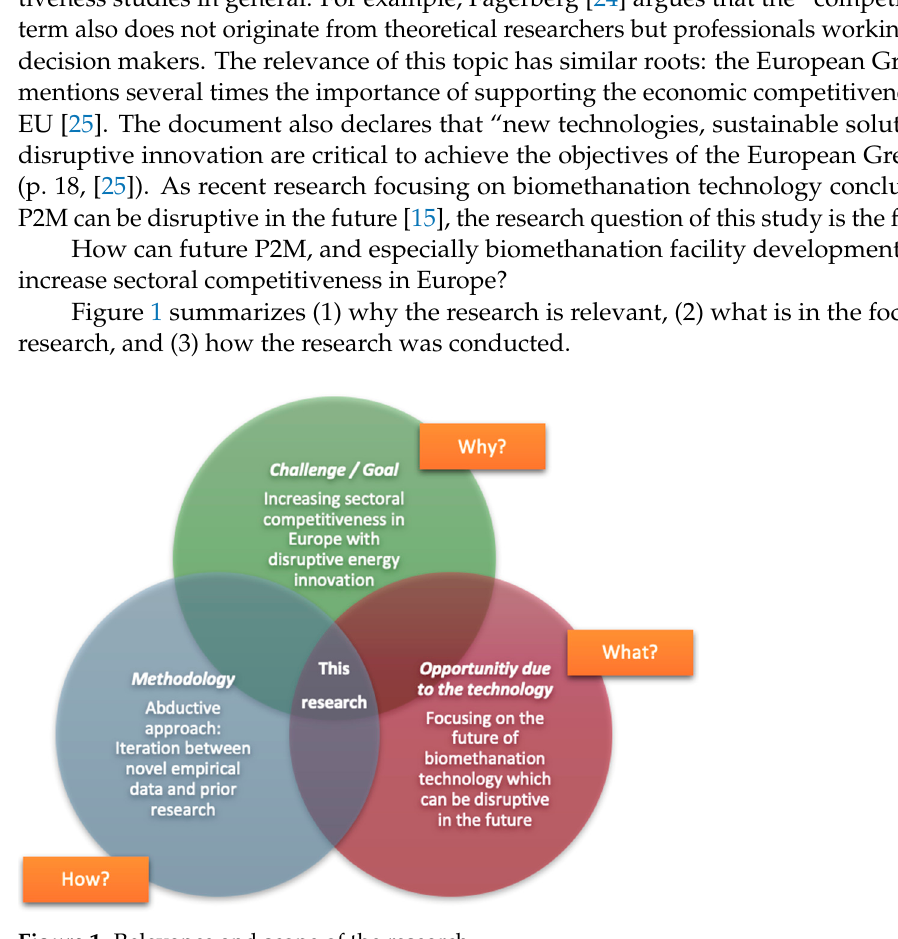
Figure 1. Relevance and scope of the research.